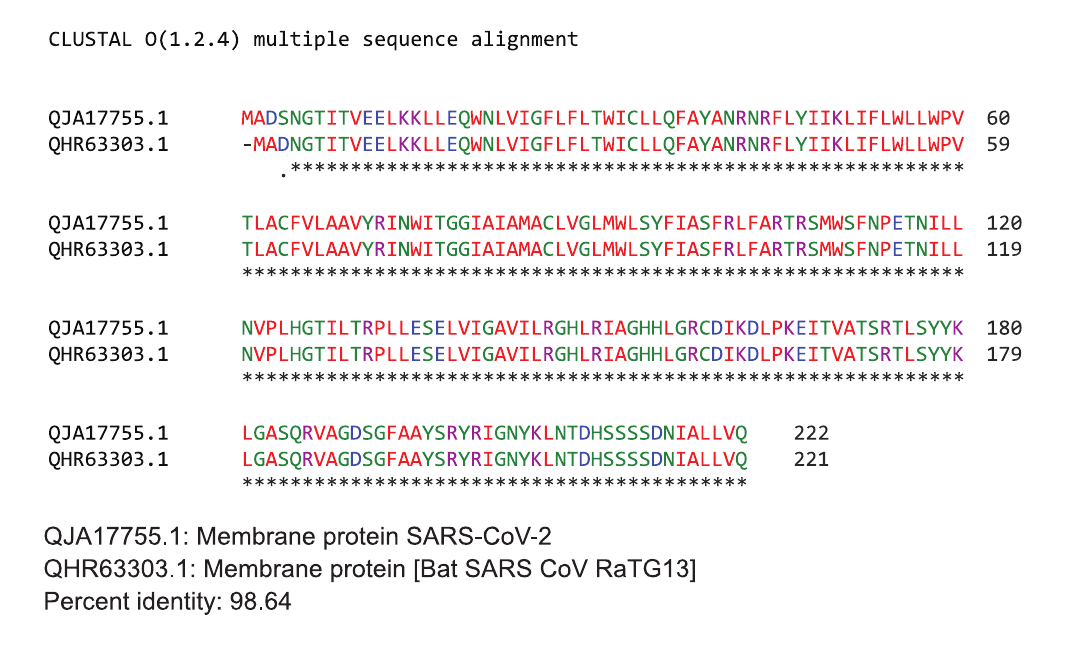
Figure 4. Protein sequences were aligned using ClustalW. Comparison of protein sequence of the M protein of SARS-COV-2 with (A) M protein of Bat SARS-CoV, (B) M protein of pangolin SARS-CoV, (C) M protein of SARS-CoV, and (D) MERS-CoV.